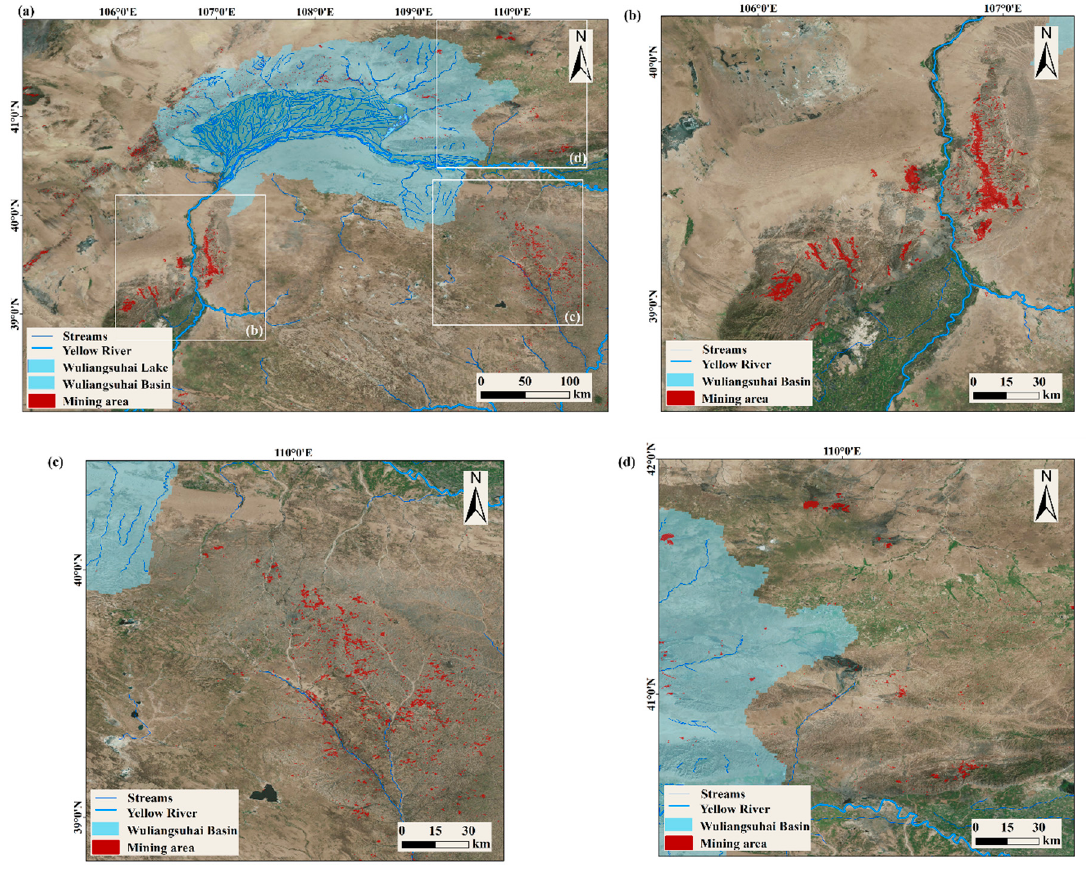
Figure 5. Distribution of mining areas segmented and classified by the MRIS and RF algorithm with streams, Yellow River, Wuliangsuhai Lake, and basin. ( a ) The distribution of mining areas and the distance to water bodies in the whole study area, ( b ) the southwestern part of the study area where the Yellow River goes through, ( c ) the southeast of the study area with streams, and ( d ) the northeast of the study area close to or in the Wuliangsuhai Basin.